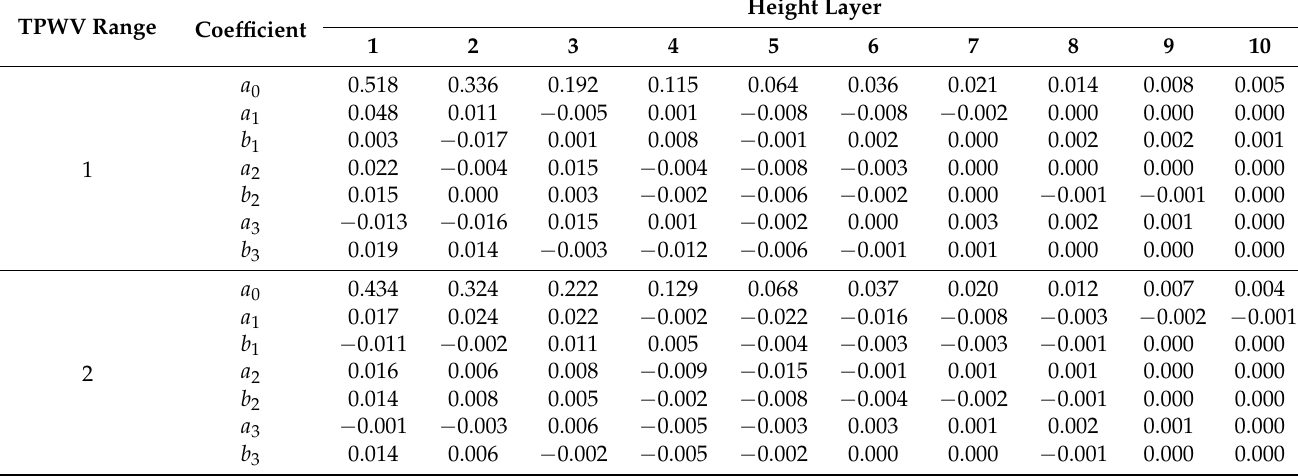
Table A1. Coefficients of the IRPWV model for all the layers within the six TPWV r at KOWLOON